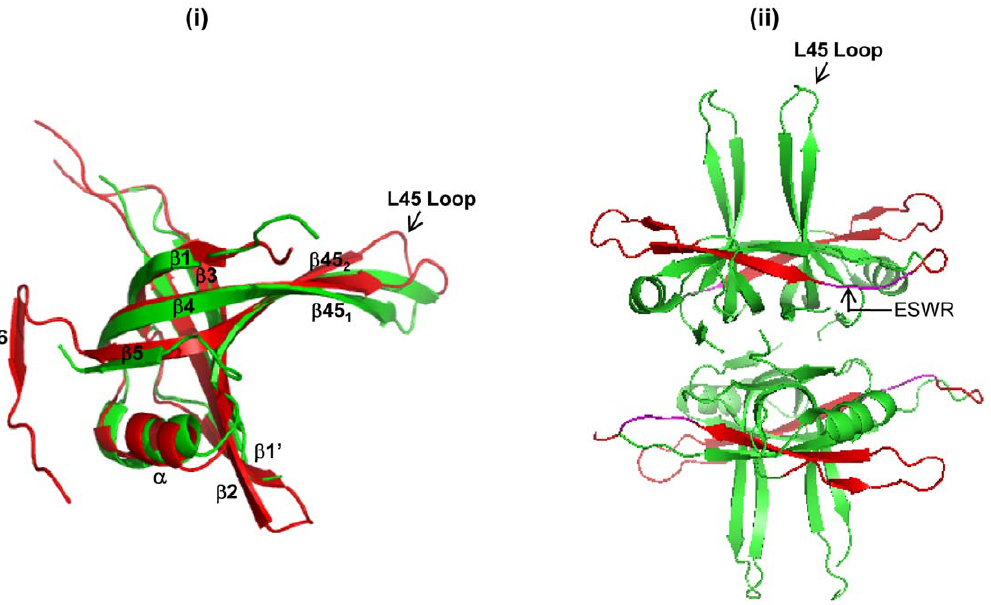
Figure 1. Comparison of tertiary and quaternary structures of Eco SSB and Mtu SSB. (i) Tertiary structures of Eco SSB and Mtu SSB are represented in green and red, respectively. The secondary structure elements including the b 6, which facilitates formation of a hook like structure in Mtu SSB [32] are as shown. (ii) Quaternary structure of Eco SSB highlighting the regions away from the subunit-subunit interface. A ribbon diagram of SSB (PDB 1KAW) is depicted through PyMol (http://www.pymol.org/). The region corresponding to b 1 9 and b 2 is shown in